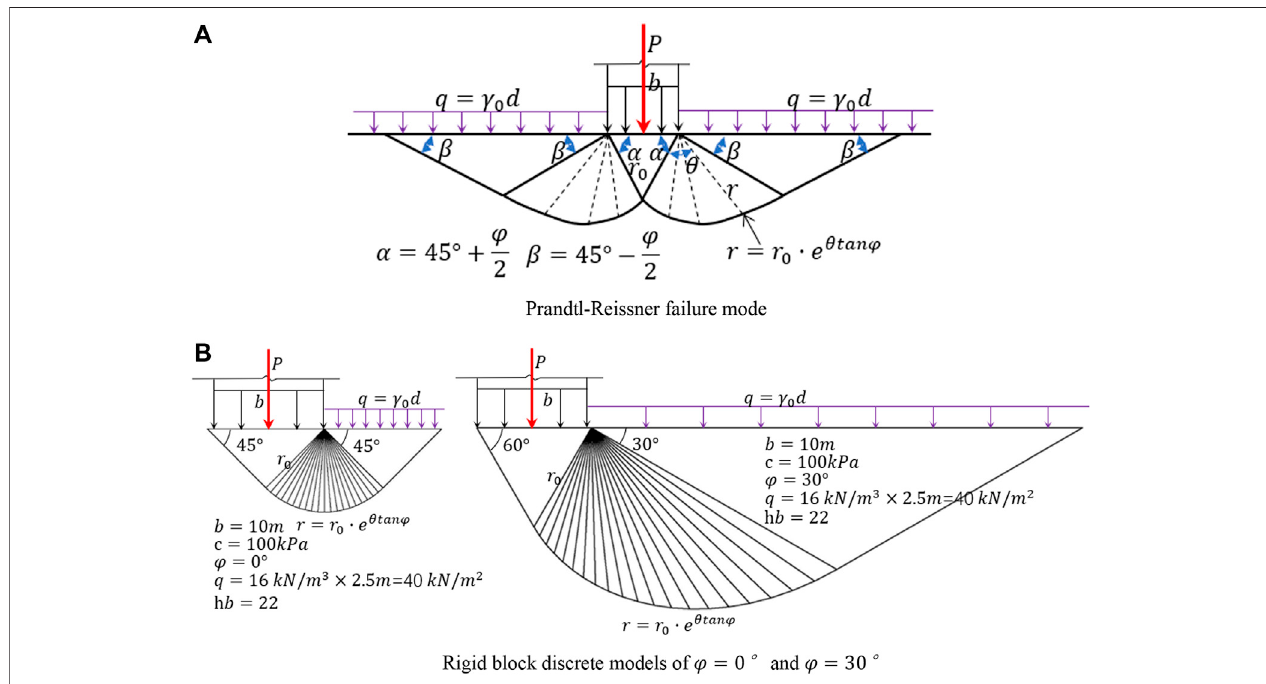
FIGURE 6 | Prandtl – Reissner failure mode and rigid block discrete. (A) Prandtl – Reissner failure mode. (B) Rigid block discrete models of φ (cid:1) 0 ° and φ (cid:1) 30 °